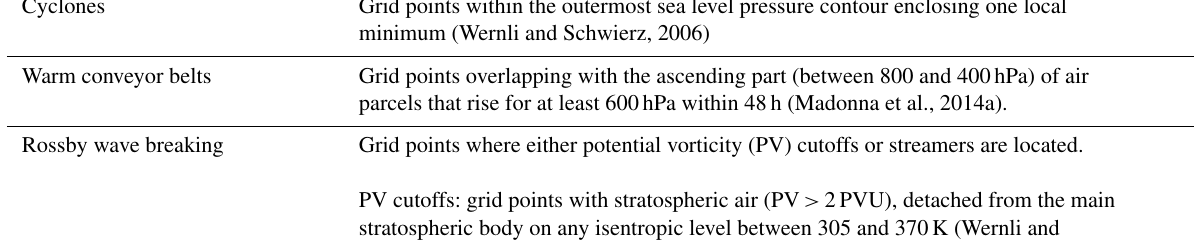
Table 1. Short description of the six objectively identified weather systems. Cyclones Grid points within the outermost sea level pressure contour enclosing one local minimum (Wernli and Schwierz, 2006)